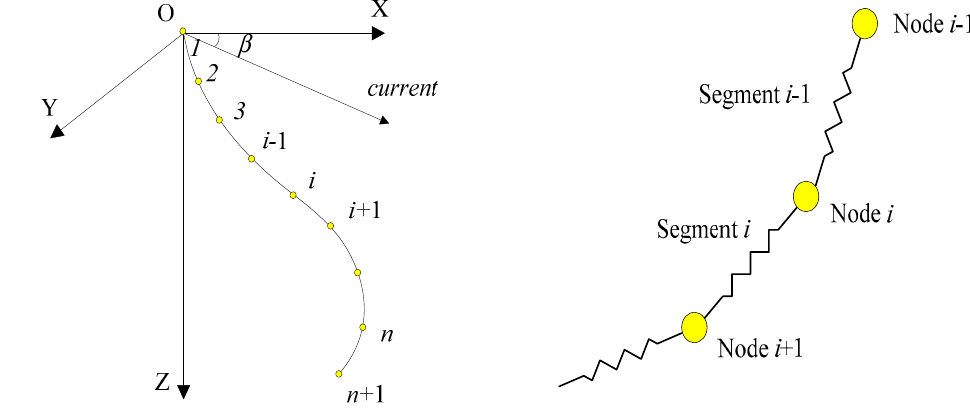
Figure 4. Discrete cable obtained using the lumped mass method.